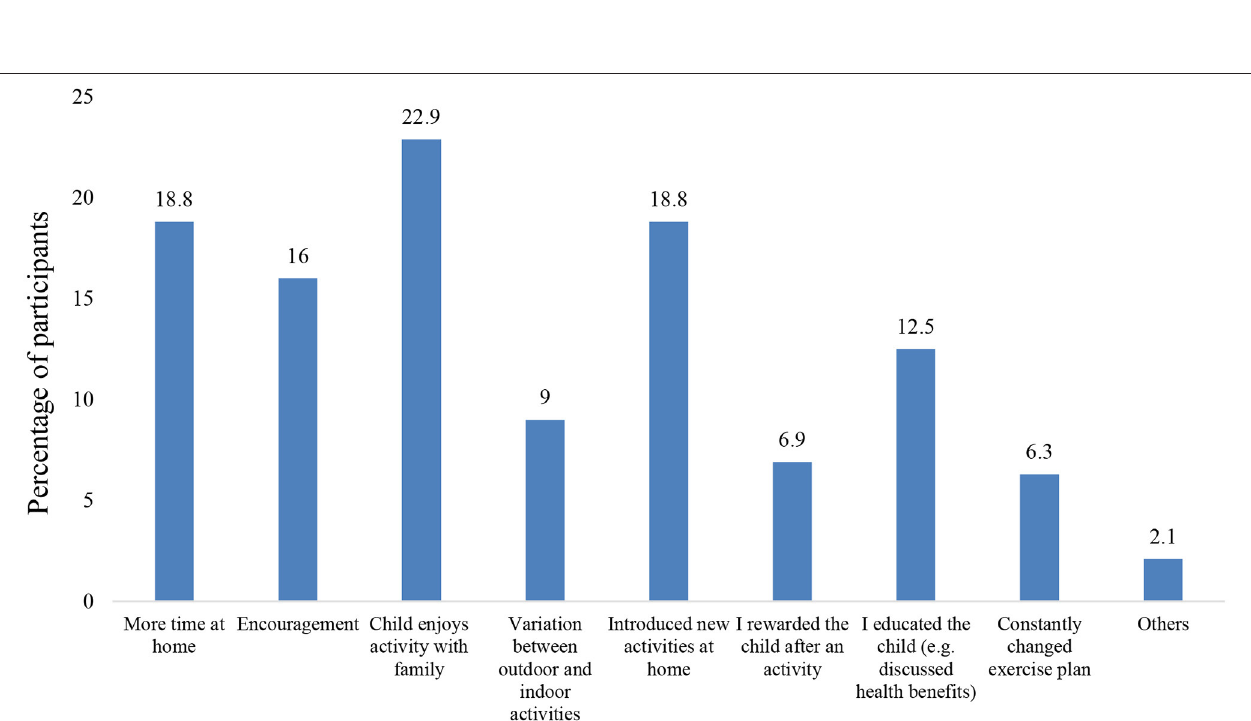
FIGURE 2 | Factors that increased the child’s physical activity during quarantine.